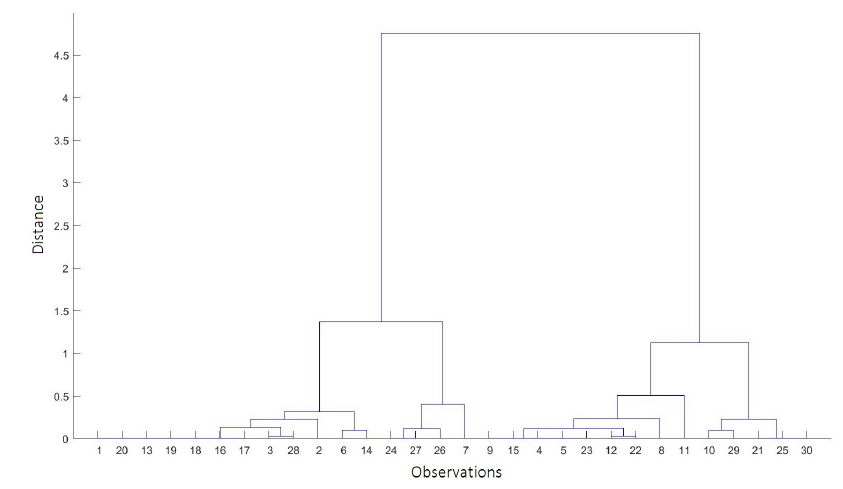
Figure 8. Dendrogram presenting the cluster hierarchy.